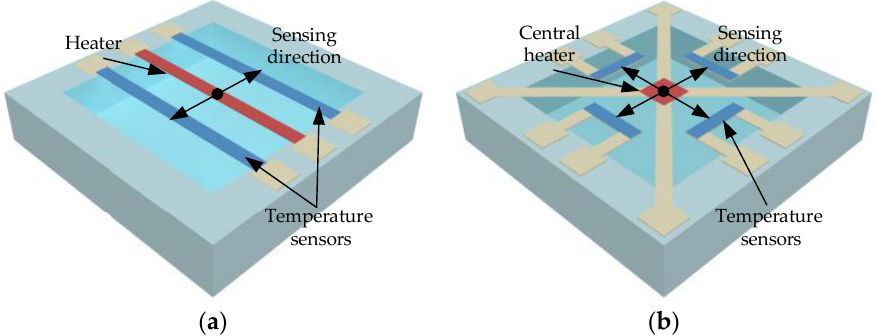
Figure 4. Illustrations of thermal convection accelerometer, ( a ) uniaxial accelerometer; ( b ) dual-axis accelerometer. ( b ) dual-axis